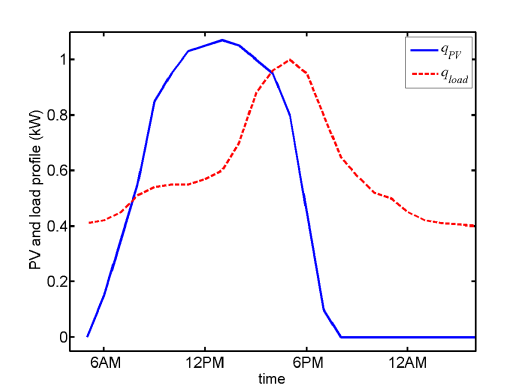
Figure 10. Inputs to the power flow model with q pv (the electric power flow entering the photovoltaic panel) and q load (the power demand of the